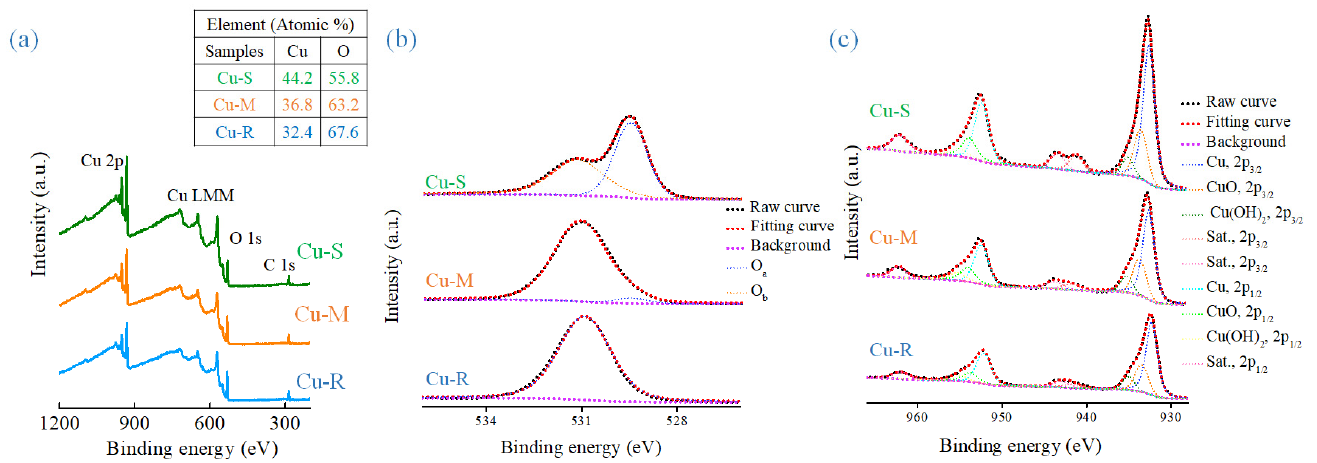
Figure 3. XRD patterns of Cu-R, Cu-M, and Cu-S.